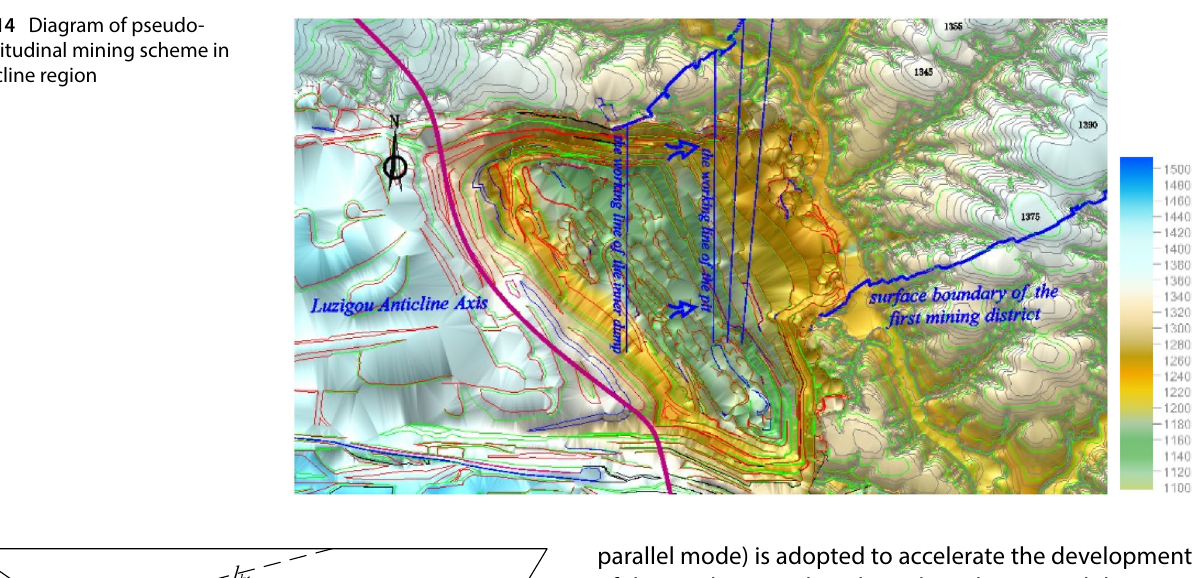
Fig. 14 Diagram of pseudo- longitudinal mining scheme in anticline region